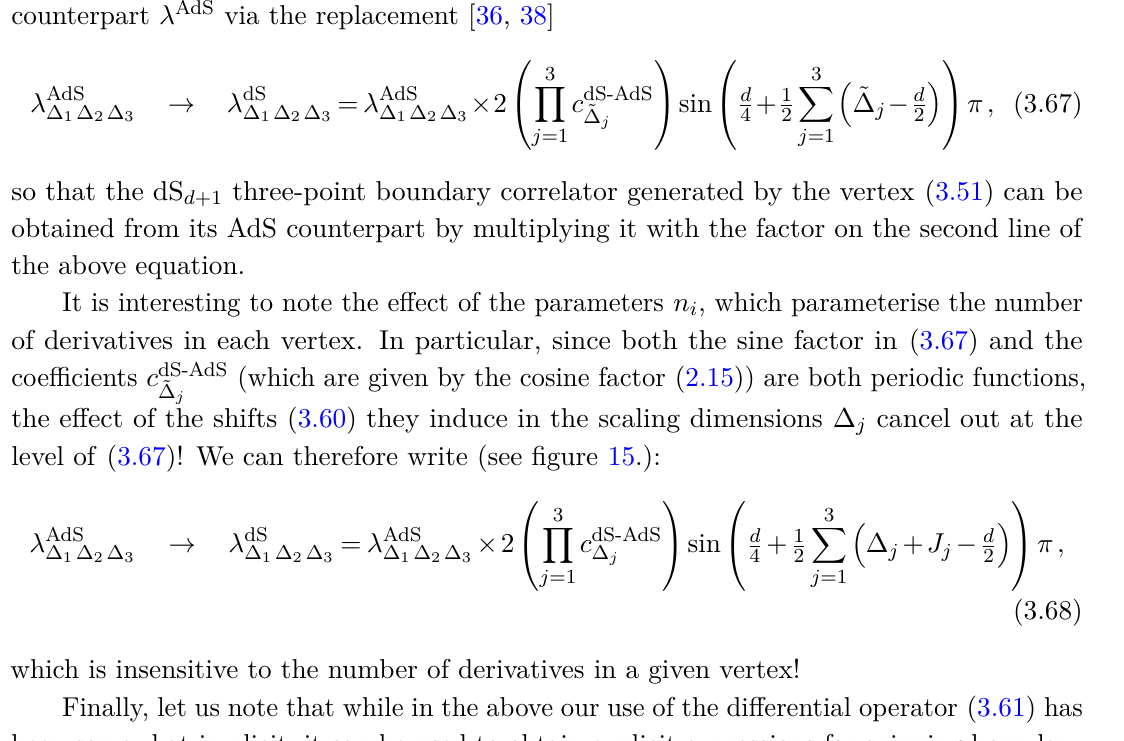
— it is the same for J 1 ,J 2 ,J 3